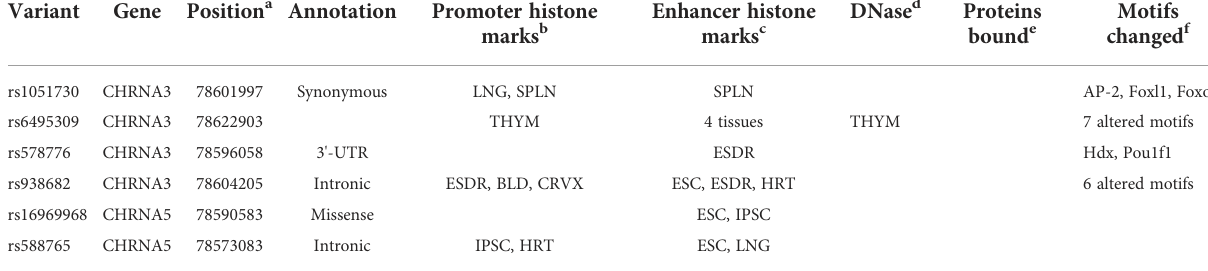
TABLE 2 Summary of functional annotations for six SNPs in CHRNA genes with diseases risk (strong epidemiological credibility).